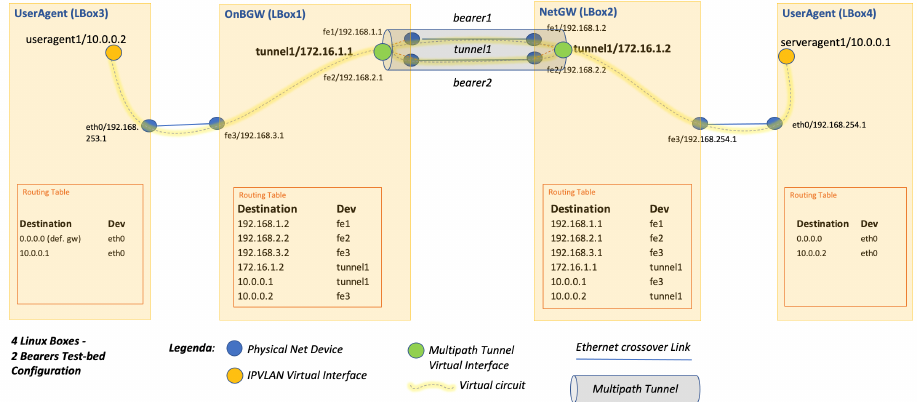
Figure 8. ACS simulator: testbed